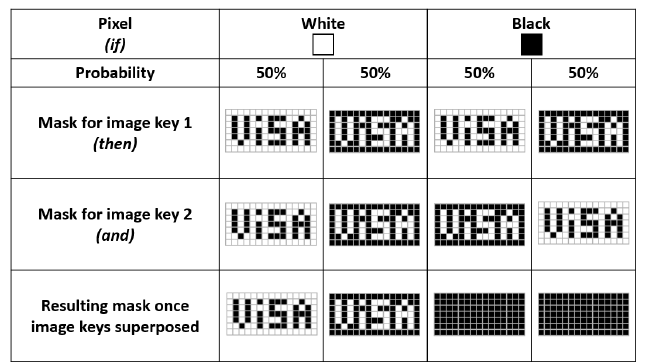
Figure 7. Principle of pictogram-based VC exploiting personalized positive and negative masks. The produced masks are derived from an advertising logo and are entirely complementary once superposed (see the bottom right mask).